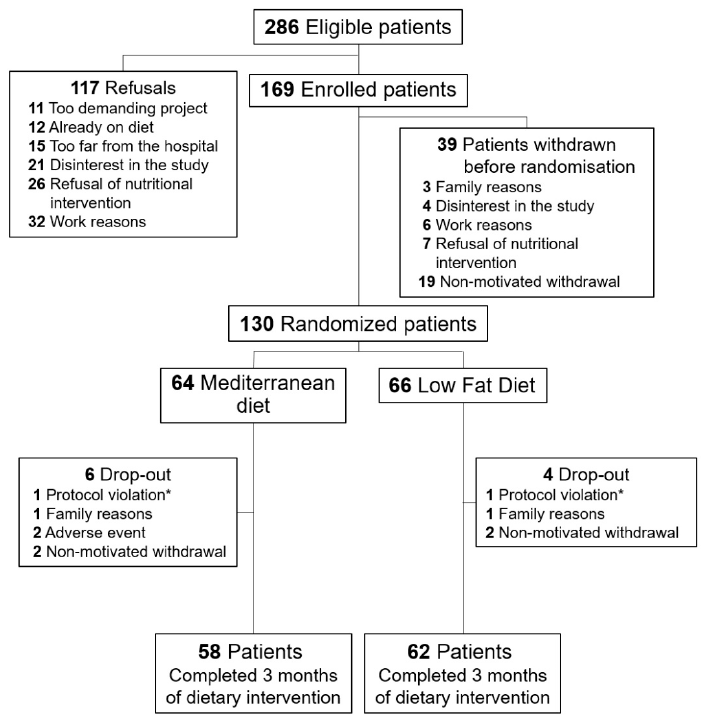
Figure 1. Recruitment chart. * Unnoticed intake of supplements containing omega − 3 fatty acids.